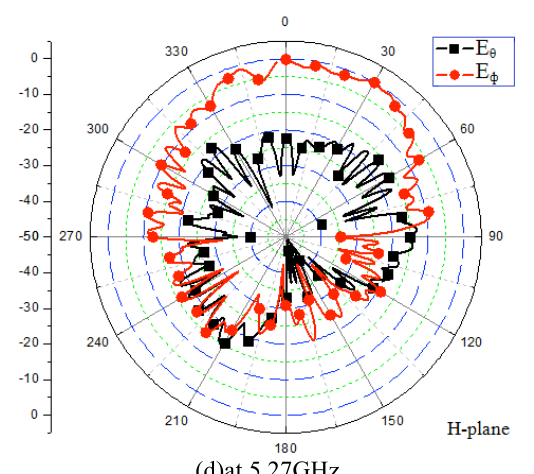
Fig. 11. Measured radiation patterns of antenna integrated with AMC at a) 2.44 GHz, b) 5.27GHz.